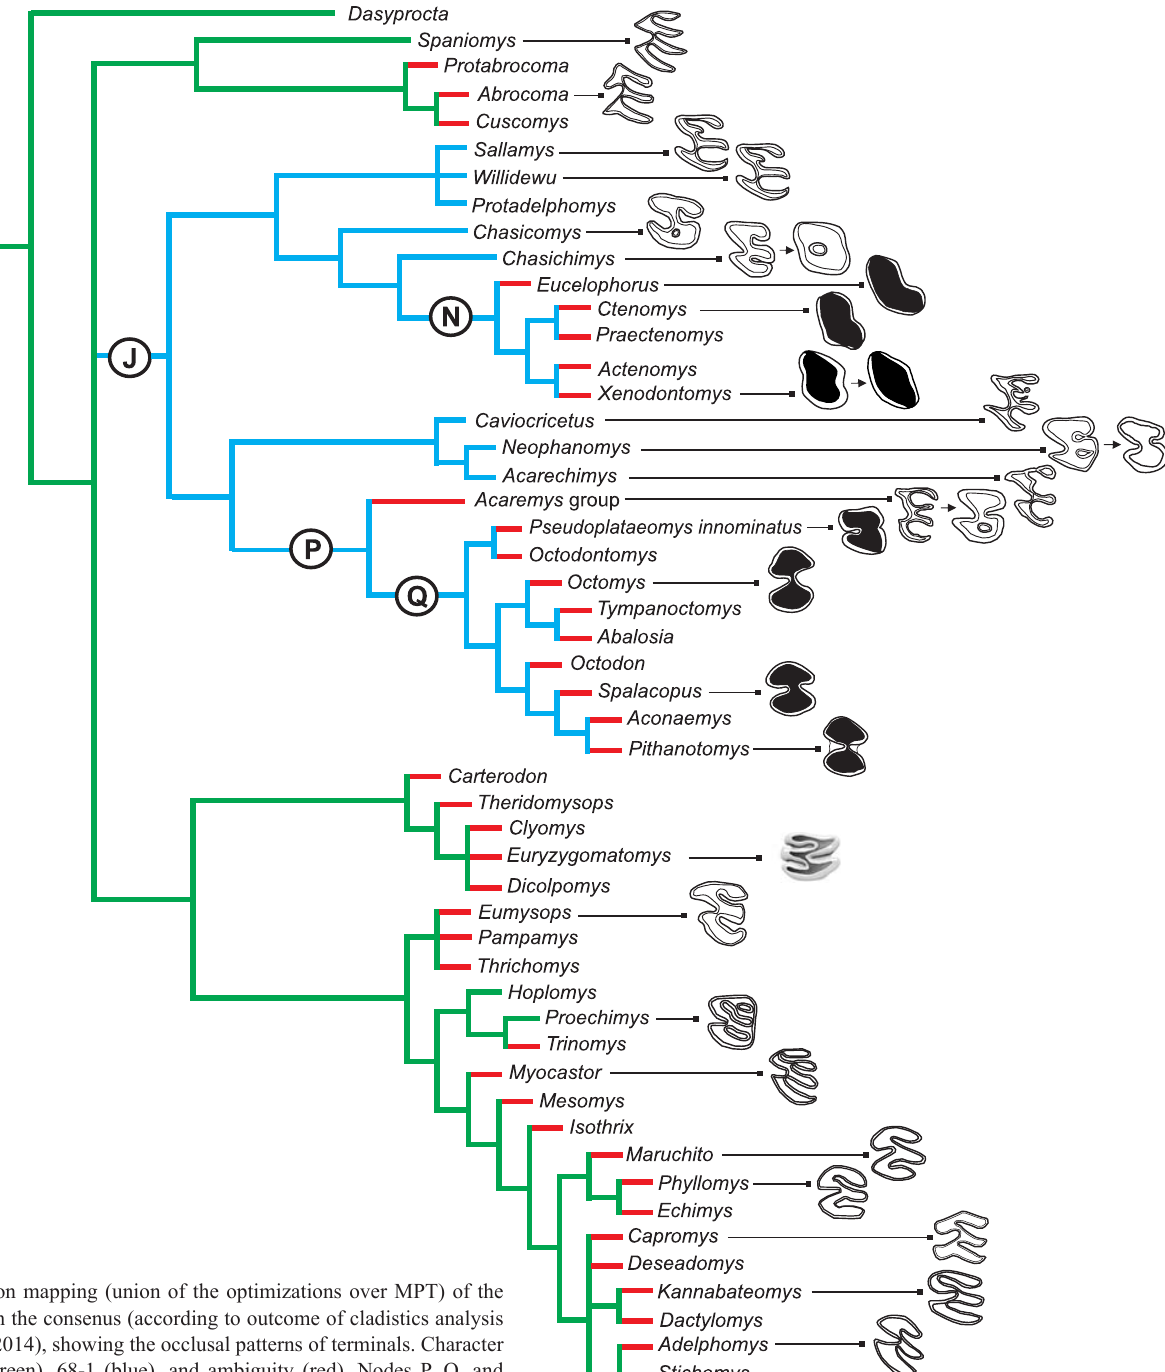
Fig. 5. Common mapping (union of the optimizations over MPT) of the character 68 on the consenus (according to outcome of cladistics analysis of Verzi et al. 2014), showing the occlusal patterns of terminals. Character states: 68-0 (green), 68-1 (blue), and ambiguity (red). Nodes P, Q, and N show clades as in Fig. 3. Node J clusters the traditionally recognized Octodontinae and Ctenomyinae with genera previously included in other taxa of Octodontoidea. Occlusal figures of terminals represent left m1 or m2 and were essentially modified from Verzi et al. (2014: fig.